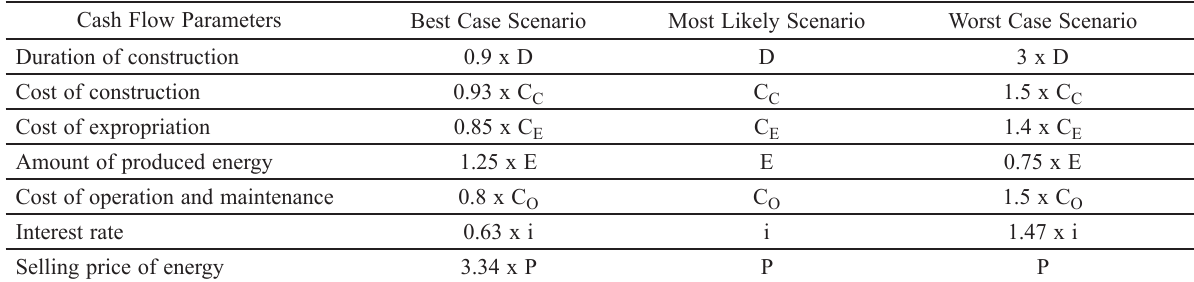
Table 3. Probability distributions for cash flow elements